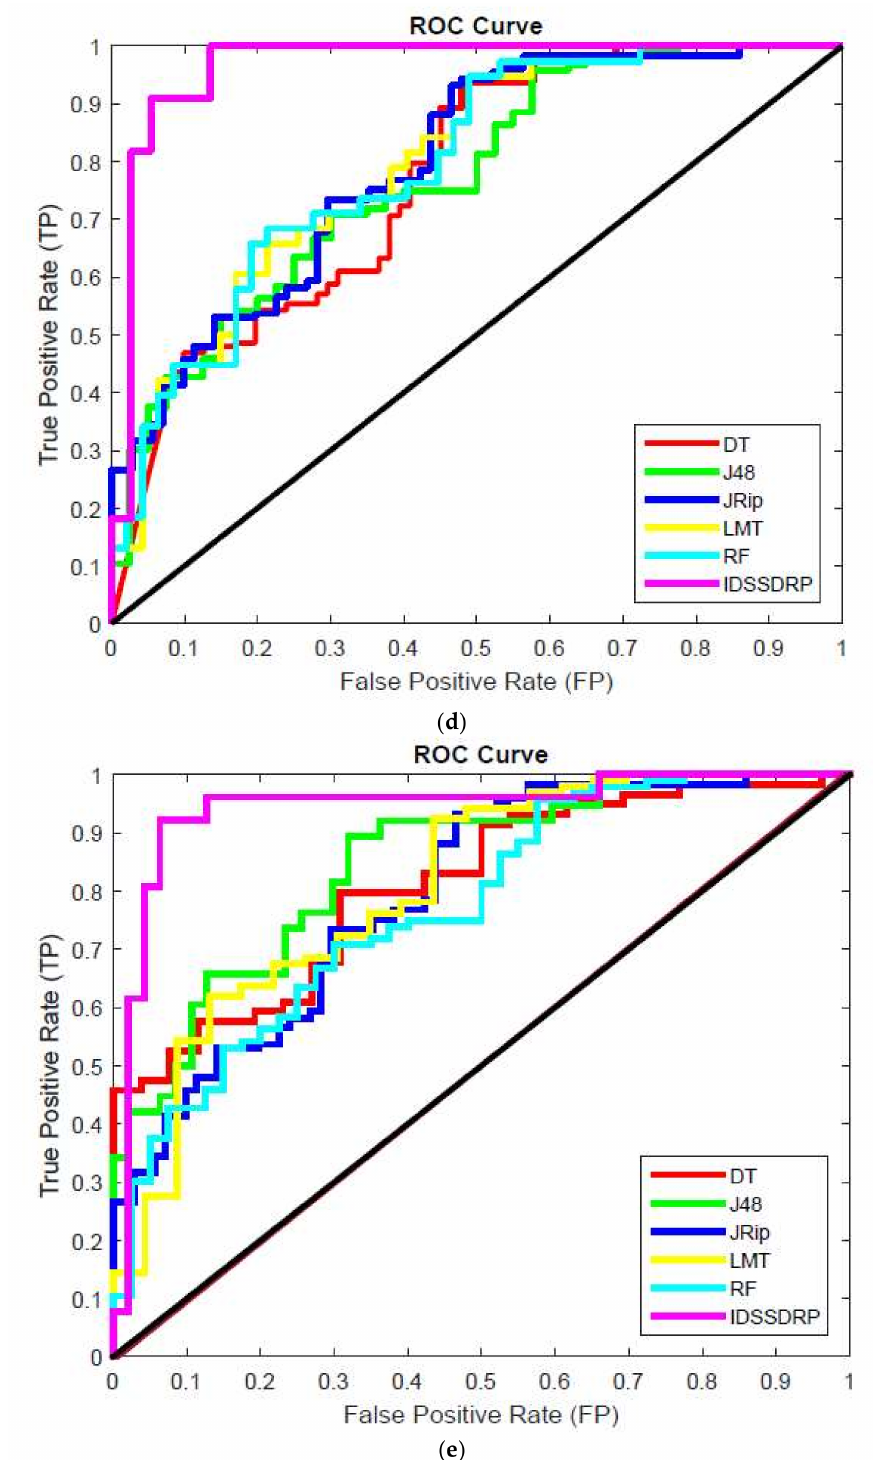
Figure 10. ROC curve analysis. as ( a ) IDSSDRP method - GLCM_0; ( b ) IDSSDRP method - GLCM_45; ( c ) IDSSDRP method - GLCM_90; ( d ) IDSSDRP method - GLCM_135; ( e ) IDSSDRP method - Shape and